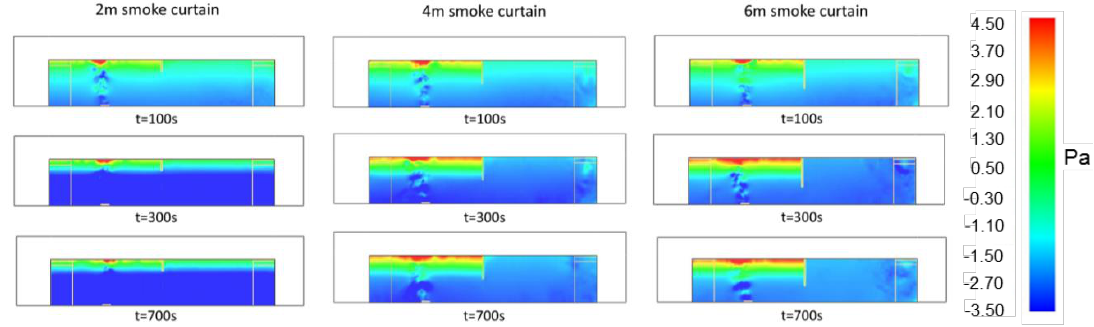
s, 300 s, and 700 s.